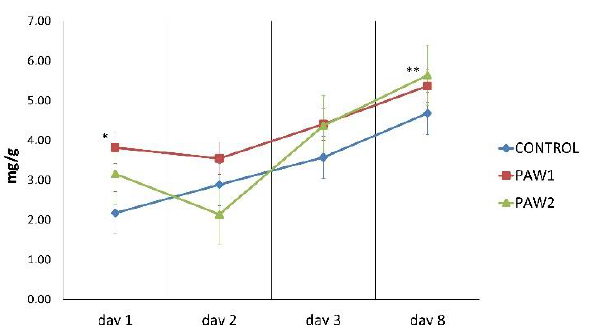
Figure 4. Effect of PAW treatment on the total protein content in Triticum aestivum L. cv. Glosa sprouts (days 1, 2, and 3) and shoots (day 8) ; * significant difference ( p < 0.05) between control and PAW1; ** significant difference ( p < 0.05) between control and PAW2. Each point represents the mean ± SD of three determinations.